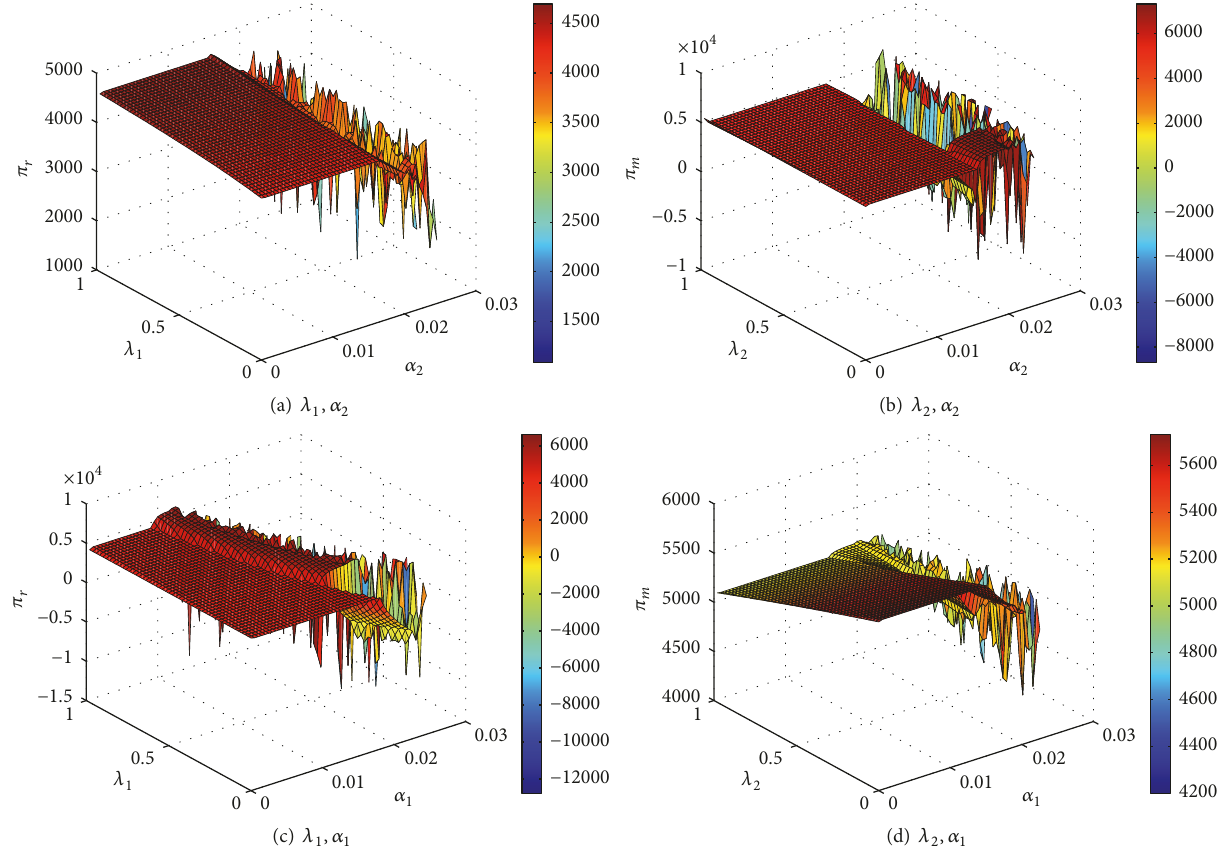
Figure 9: The change of profit of the system with respect to 𝜆 𝑖 , 𝛼 𝑖